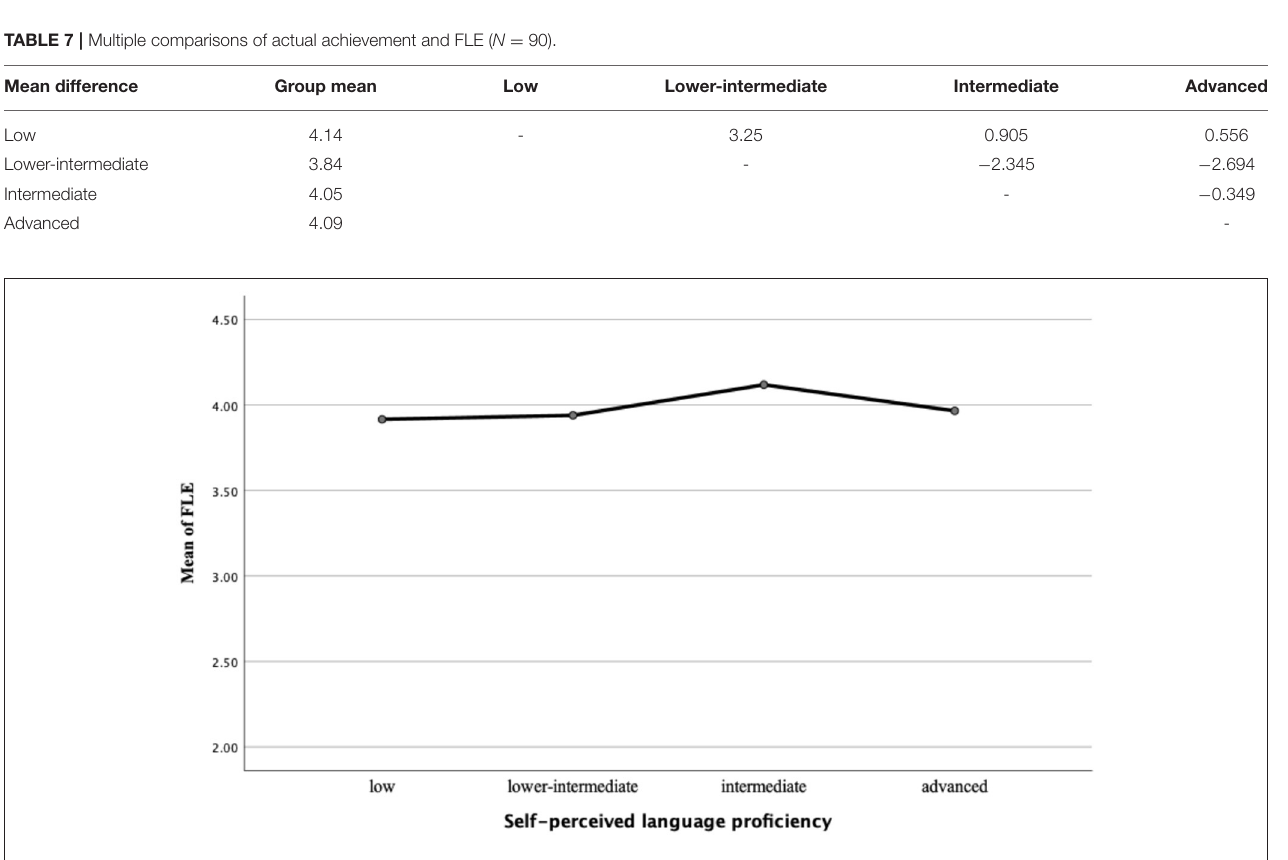
FIGURE 1 | Means of FLE and levels of self-perceived language